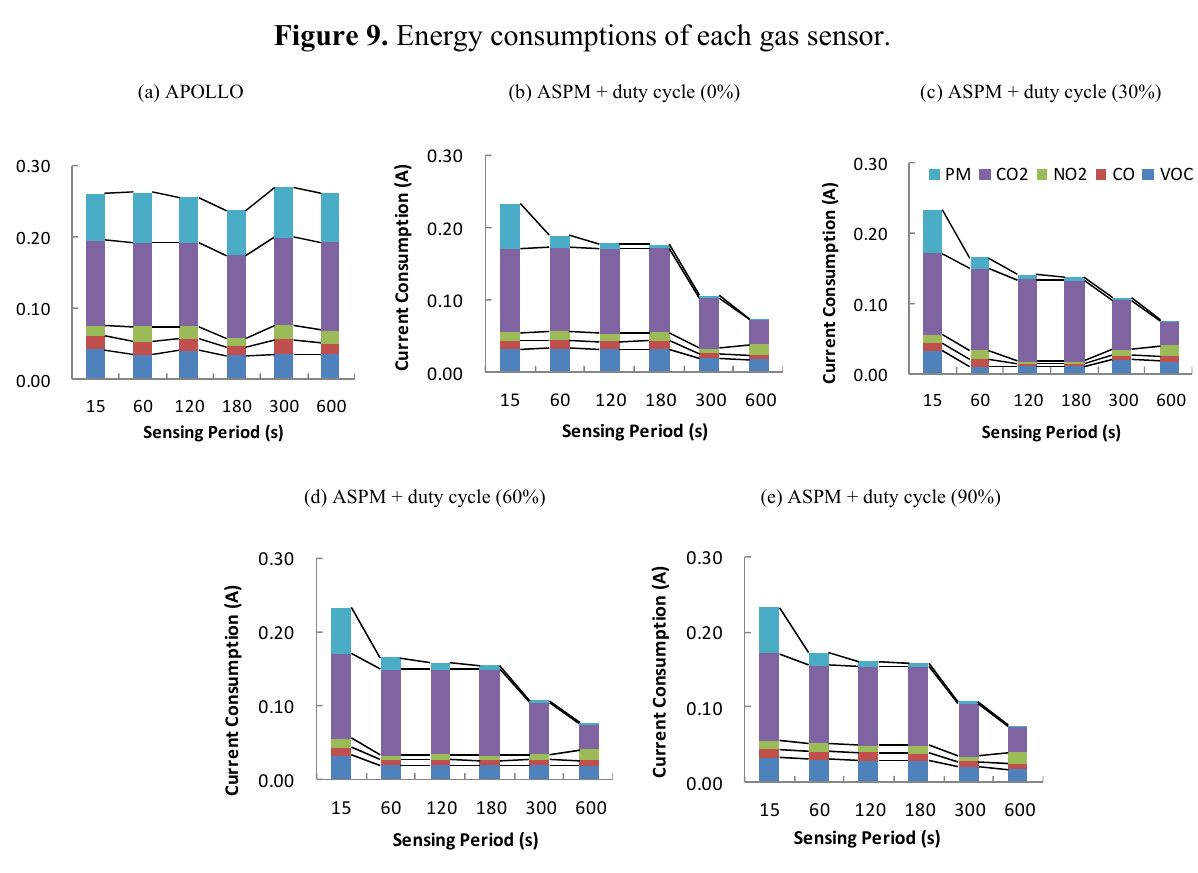
Figure 9. Energy consumptions of each gas